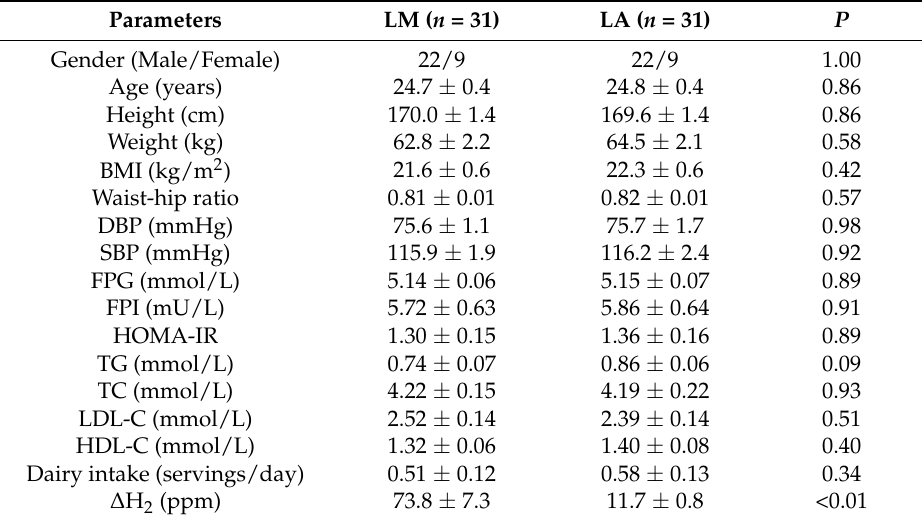
Table 1. Baseline characteristics of subjects with and without lactose malabsorption 1